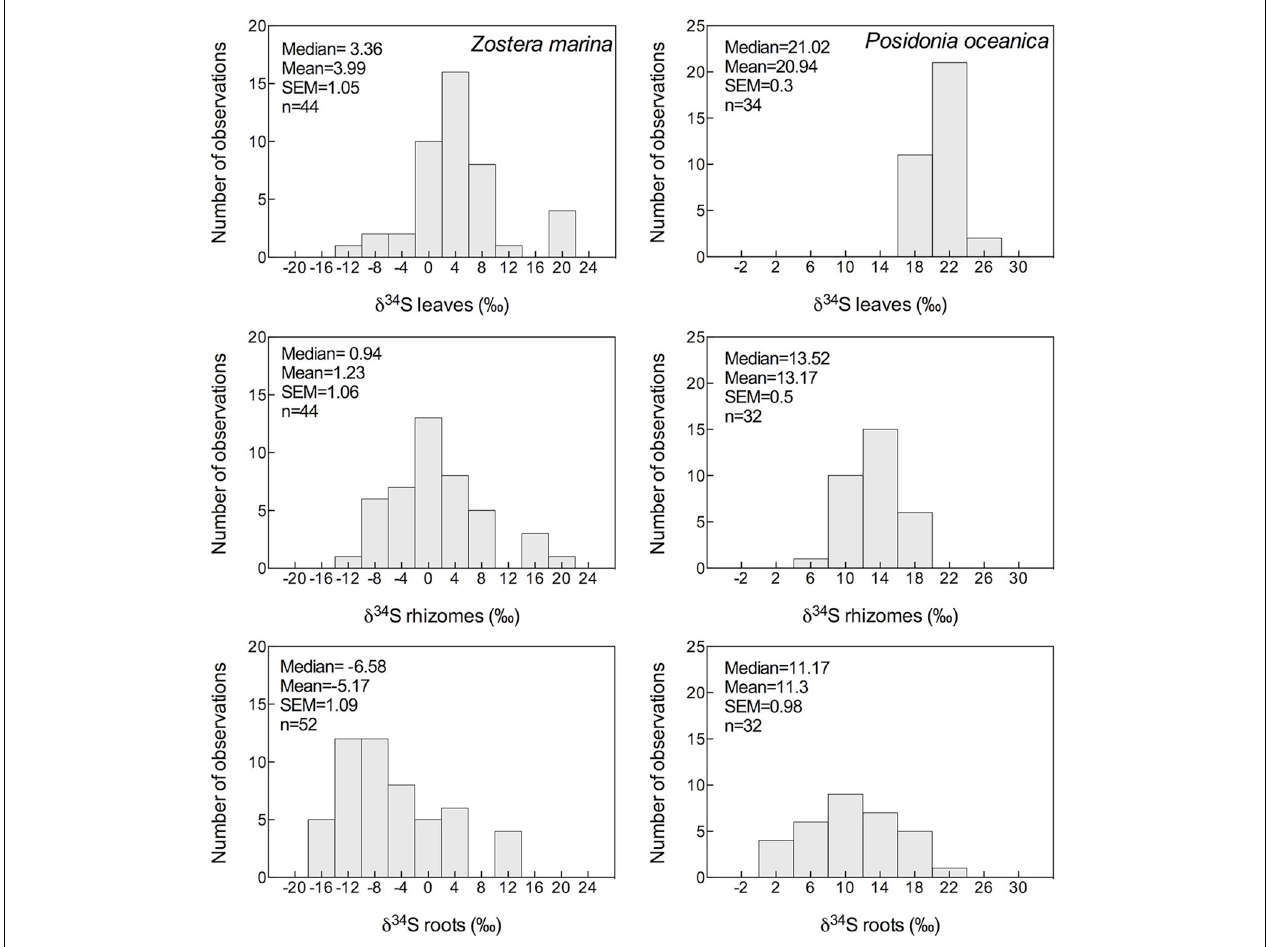
FIGURE 3 | Histograms showing the mean, median and SEM of δ 34 S of leaves, rhizomes and roots of Zostera marina (left column) and Posidonia oceanica (right column) of data available in literature; references are given in the supplementary material.